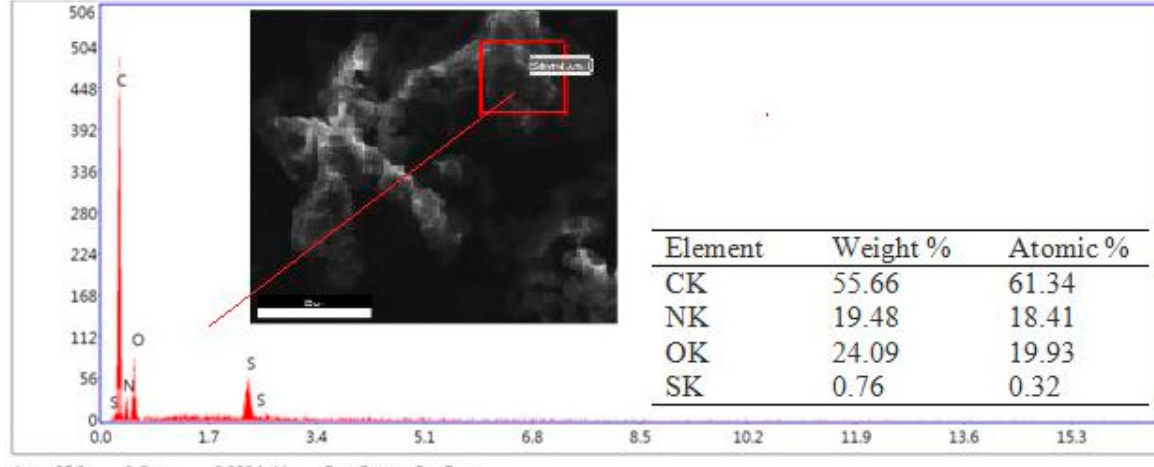
Figure 6. EDS analysis of sheep horn powder.